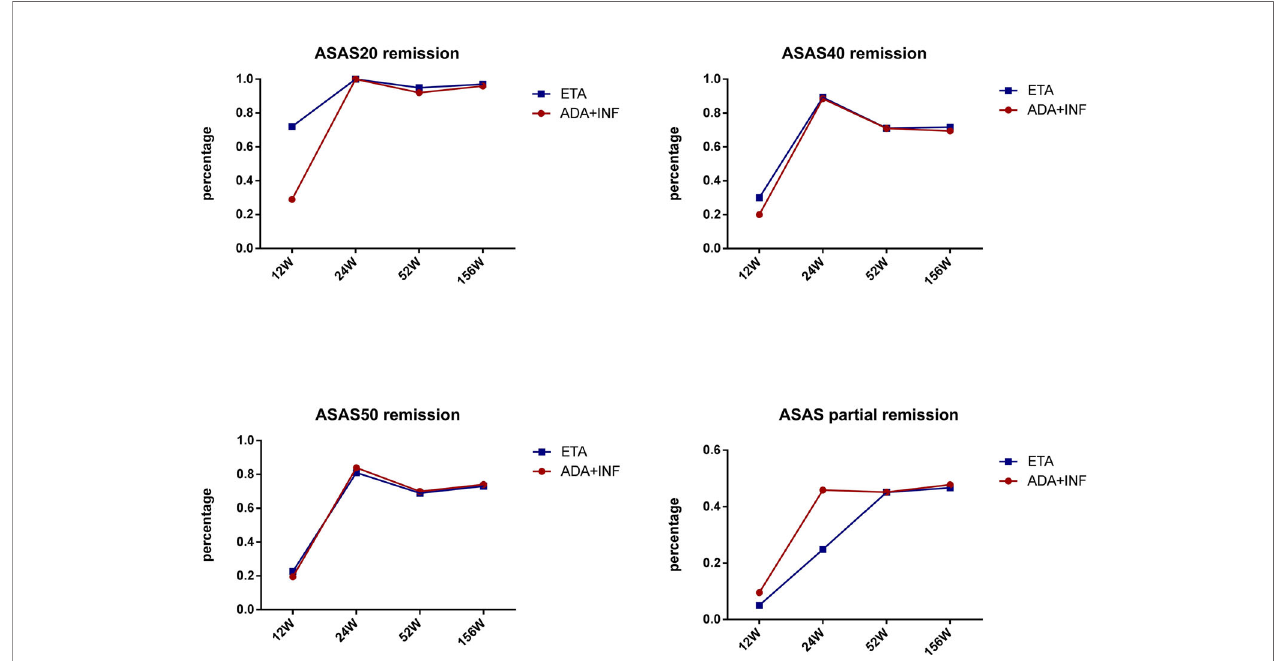
FIGURE 4 | ASAS remission rates between groups receiving different TNF- a inhibitors. ETA, etanercept; ADA, adalimumab; INF, in fl iximab; ASAS, Assessment of SpondyloArthritis international